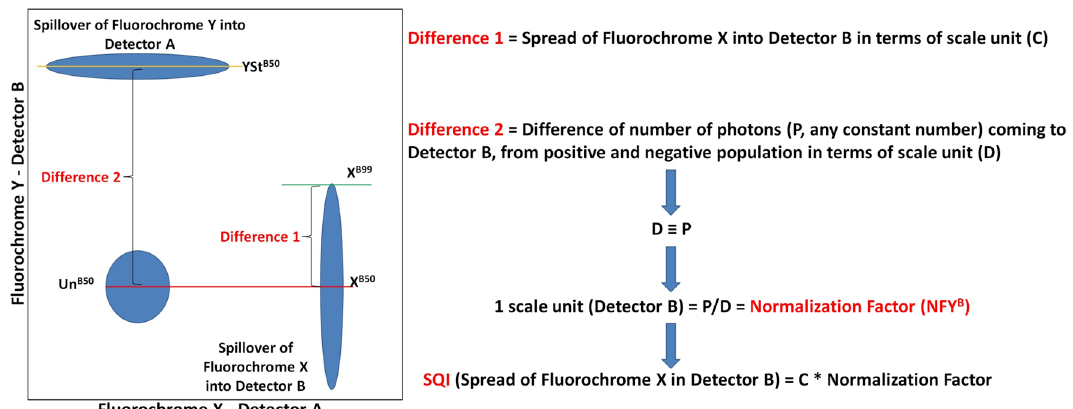
Figure 1. Concept of the SQI: The figure shows the concept of the SQI value. Spillover fluorescence from primary fluorochrome X results in spread in detector B, and vice versa. The spread is quantified as the difference of the 99th percentile and 50th percentile in dimension B. Subsequently, this value is multiplied by a normalization factor to make the SQI value independent of detector gain settings. The 99th percentile is marked by a Green